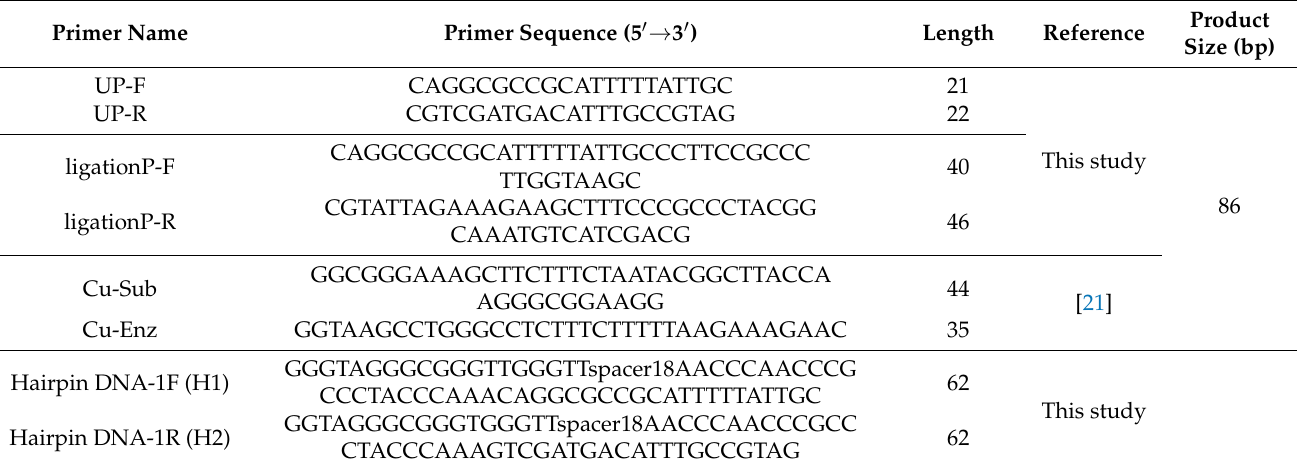
Table 1. Synthesized oligonucleotides